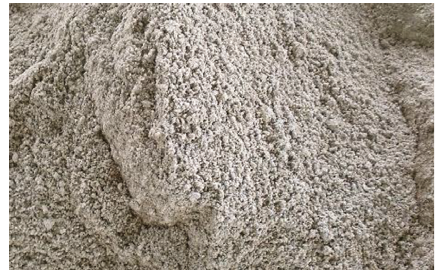
Figure 1: Natural fine aggregate.